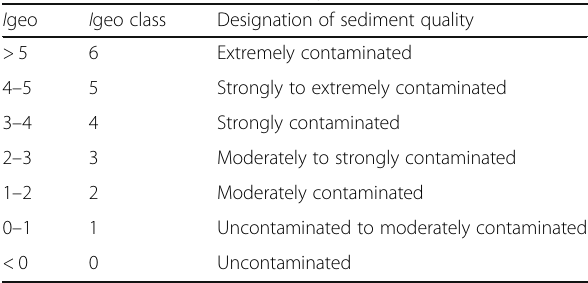
Table 2 Geoaccumulation index ( I geo ) classification [EU 1998]